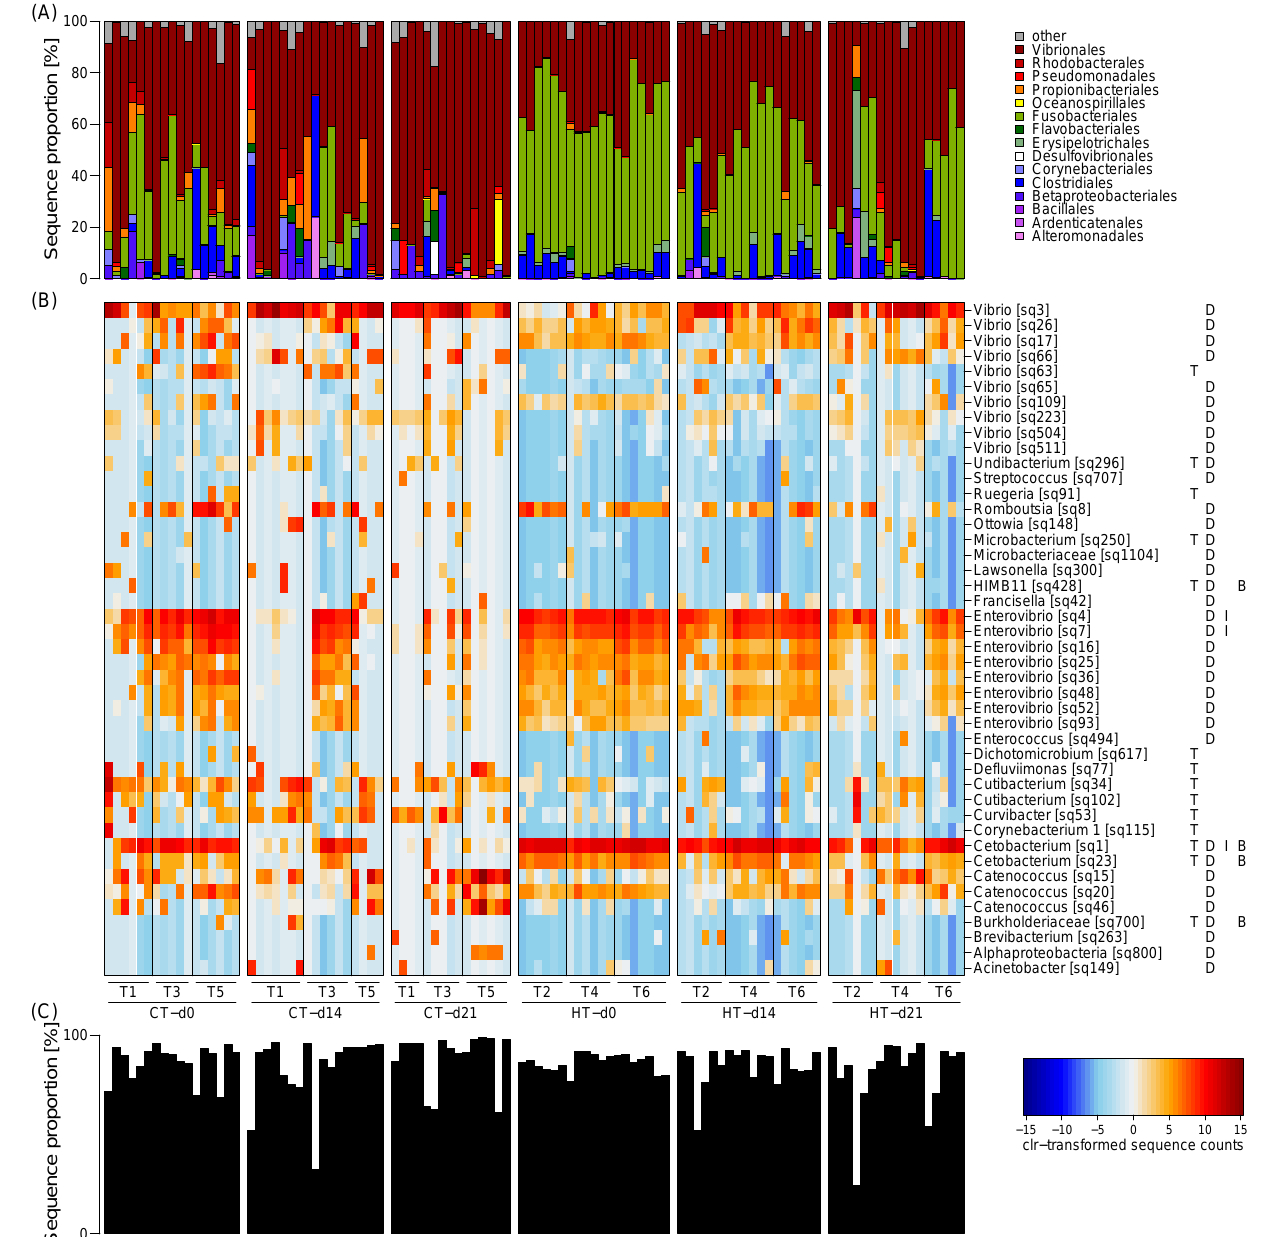
Figure 3. Taxonomic composition of the milkfish gut microbiome and differentially enriched OTUs at different temperature treatments and sampling timepoints. ( A ) Taxonomic composition at order level. ( B ) Heatmap of clr-transformed sequence counts of differentially enriched OTUs. Only dominant OTUs with at least 1% sequence proportion in one sample are shown. Genus level taxonomy and OTU names are provided on the right, followed by capital letters indicating whether differences were observed between treatments (T), timepoints (days; D), the interaction of these two factors (I), or whether they were correlated to the hepatosomatic index (biomarker; B). ( C ) Total contribution of differentially enriched OTUs to the microbiome composition. Temperature treatments: control temperature at 26 ◦ C (CT) and high temperature at 33 ◦ C (HT). Sampling timepoints: 0, 14, and 21 days after the temperature increase. Each treatment consisted of three independent tanks (T: tank